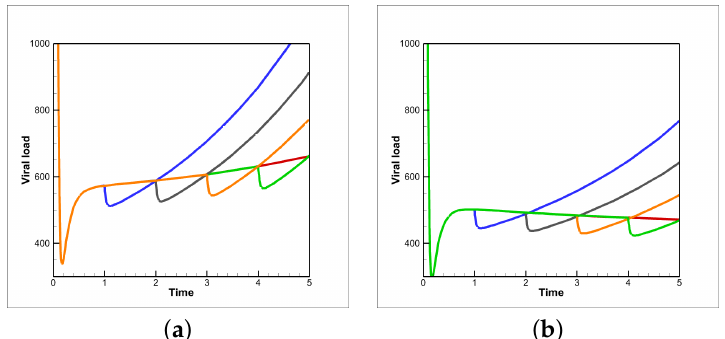
Figure 12. Viral load as a function of time for various treatment timing configurations of host-cell entry inhibitor followed by Remdesivir with patient vaccine efficacies of ( a ) 0.1 and ( b ) 0.15. Colored lines describethe time before the entry-inhibitor to Remdesivir therapy swap. Blue, black, orange, green and red correspond to one, two, three, four and five days,